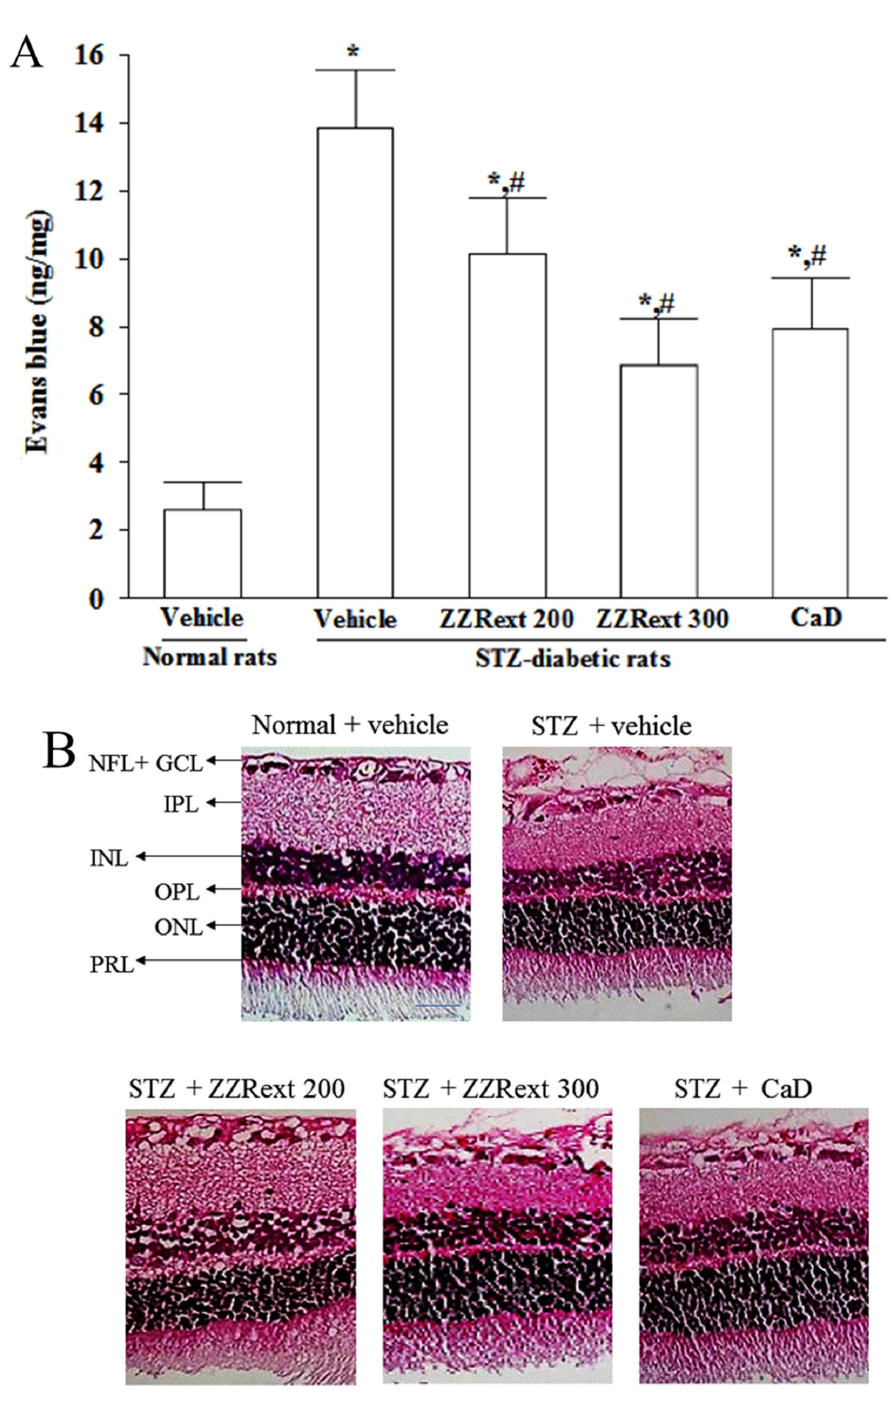
Figure 1. Figure 1. Cont.